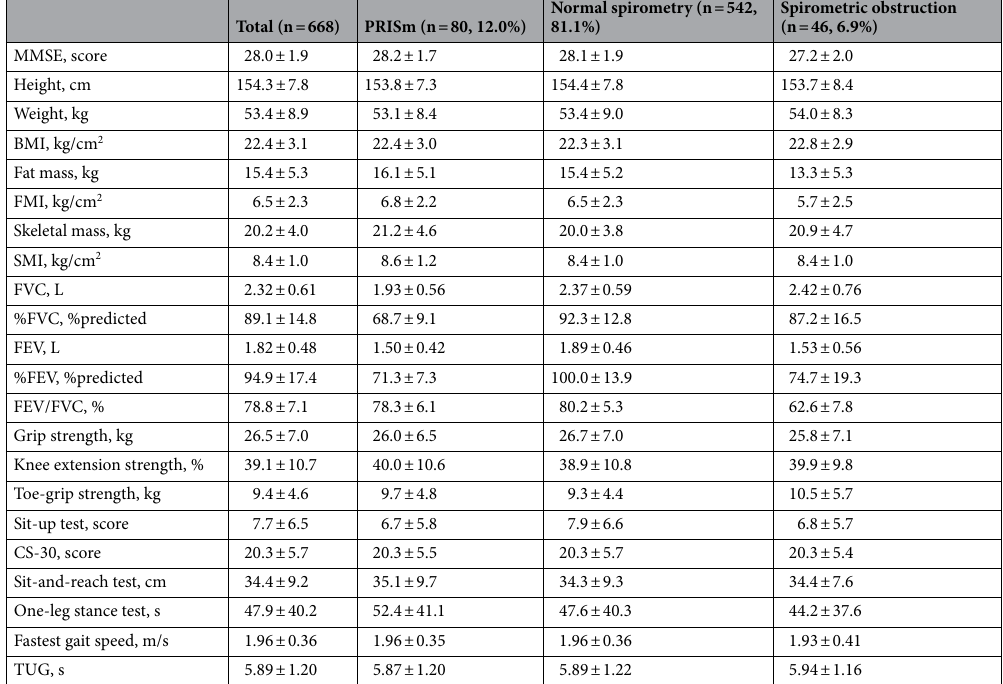
Table 2. Physiological characteristics of the PRISm, spirometric obstruction, and normal spirometry groups. BMI Body mass index, CS-30 30-s stand test, FEV Forced expiratory volume, FMI Fat mass index, FVC Forced vital capacity, MMSE Mini-mental state examination, PRISm Preserved ratio impaired spirometry, SMI Skeletal muscle mass index, TUG Timed up and